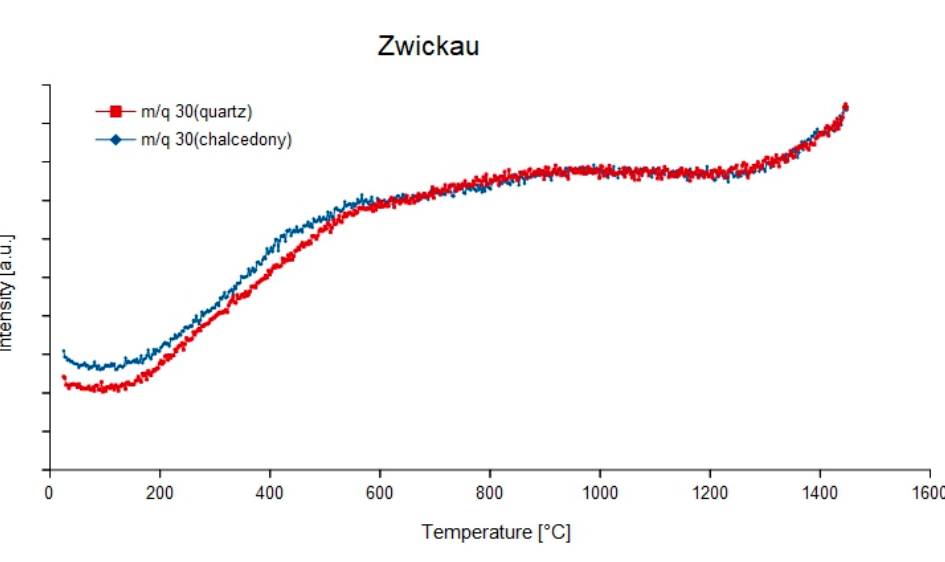
Figure 6. Continuous degassing curves of mass-charge ratio 14 (N) of the quartz and chalcedony parts in the agate from Zwickau, Germany.